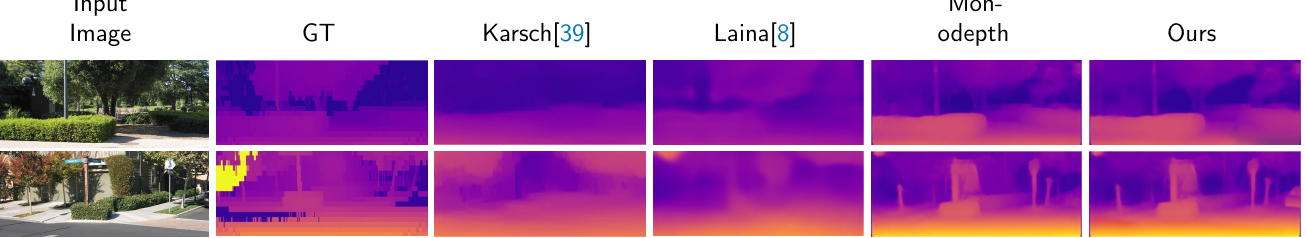
Figure 7. Results and comparison on Make3D dataset